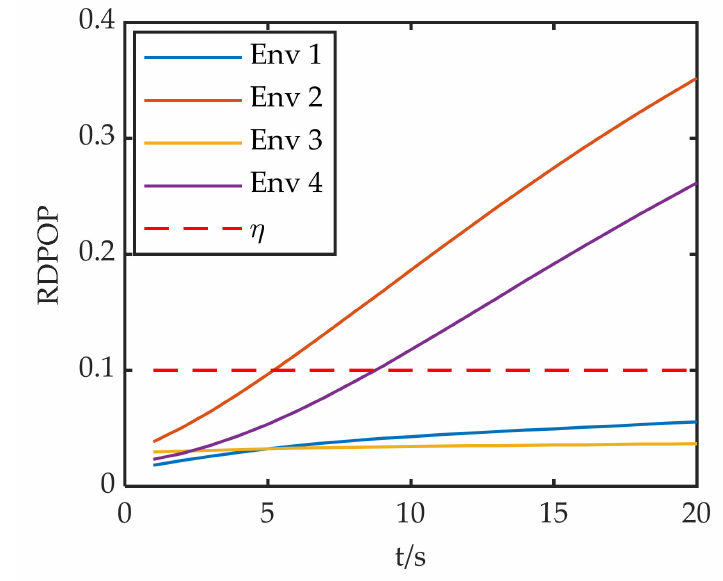
Figure 7. RDPOP of the faulty satellite in each